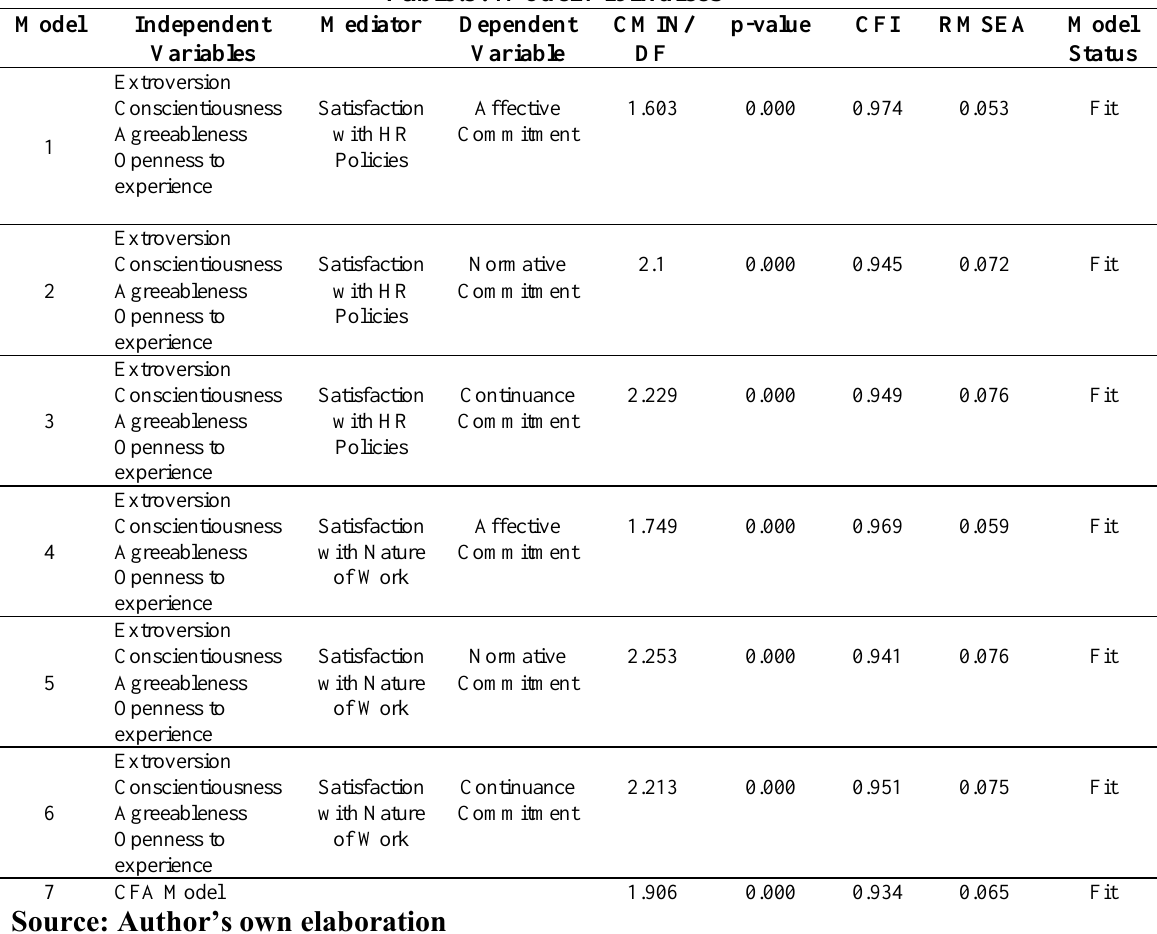
Table.3: Model Fit Indices